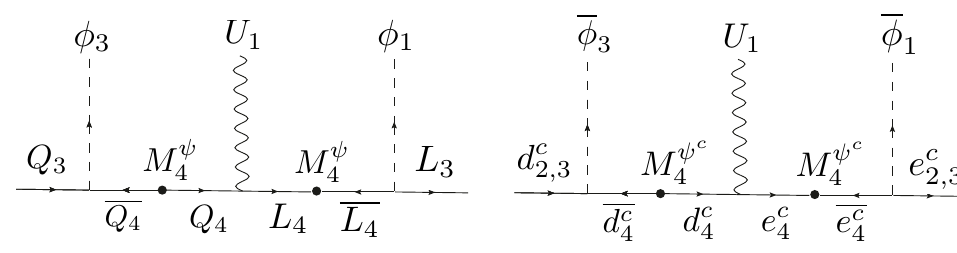
Figure 5 . Diagrams in the model which leads to the effective U 1 vector leptoquark couplings to quarks to leptons in the mass insertion approximation. The left (right) panels show the left (right) handed couplings. The diagram in the left-panel will dominate since M ψ approximate effective operator in eq.